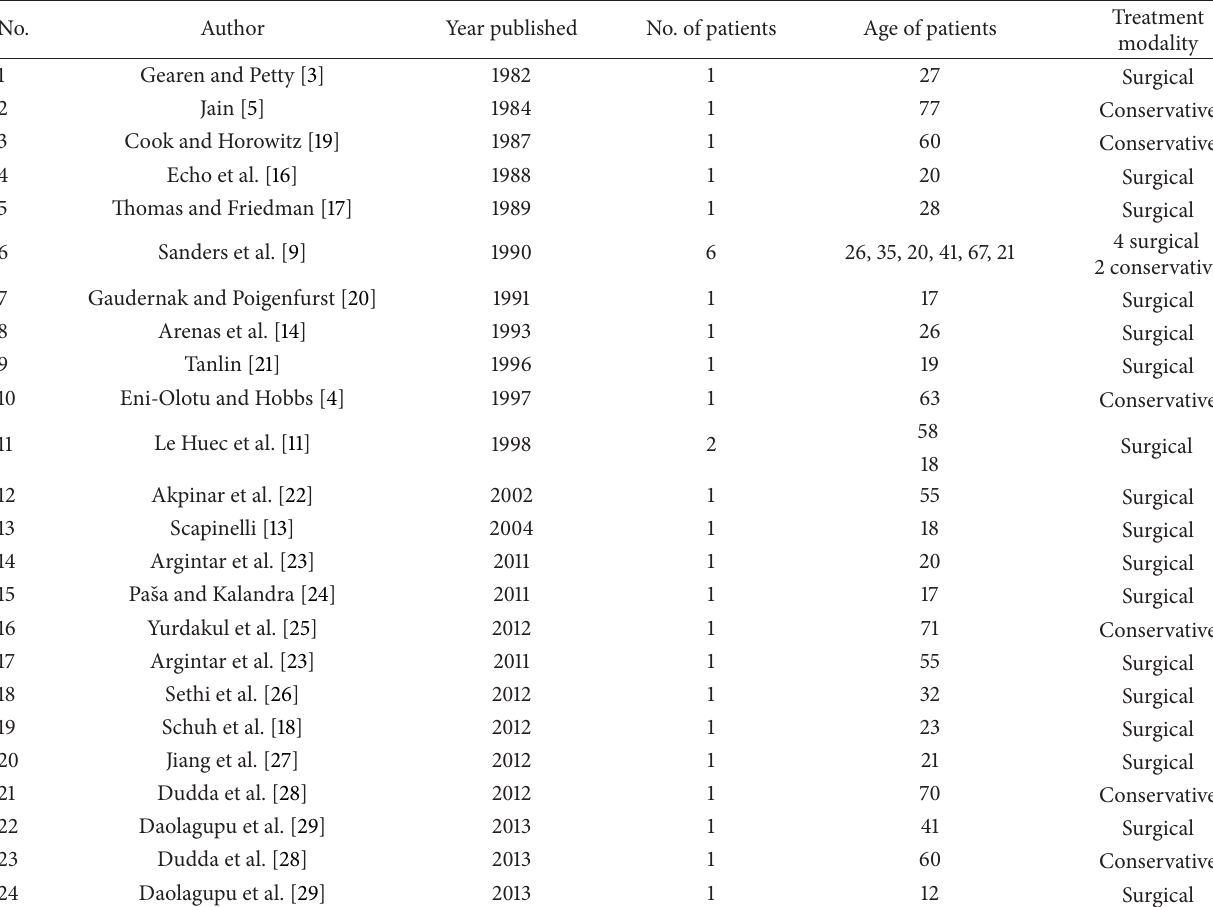
Table 1: Review of the existing literature on floating